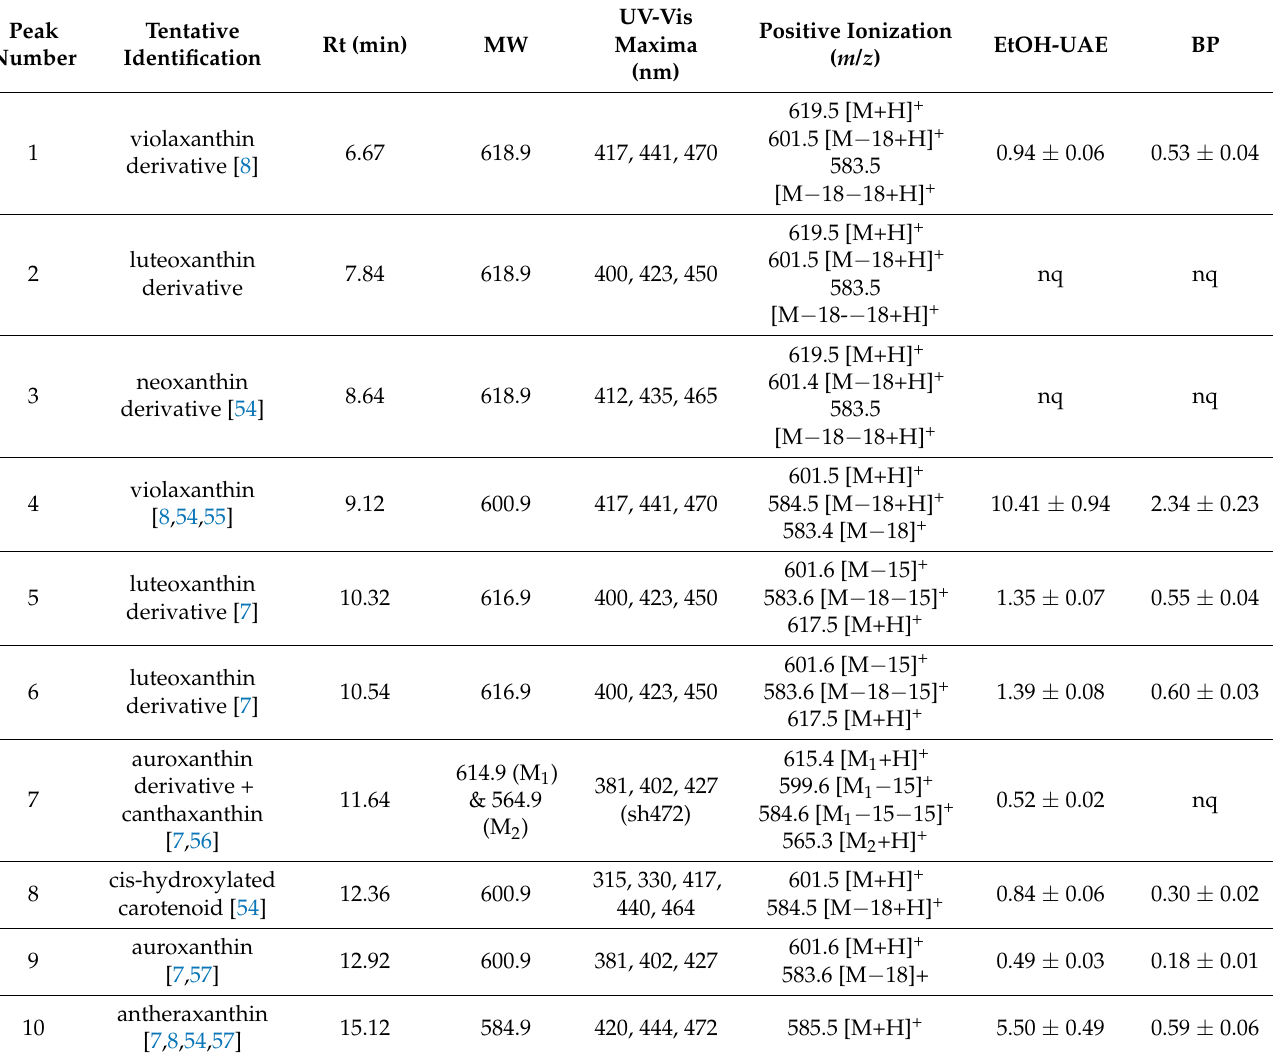
Table 3. Identification and quantification of the main compounds of the two extracts, the EtOH-UAE and the BP. Peaks were tentatively identified after comparison of the UV-vis maxima obtained by the HPLC-DAD and UHPLC-DAD-MS analysis, the ions observed in the mass spectra after UHPLC- DAD-MS, and their elution order to the literature. The retention times of the HPLC-DAD analysis used for quantification are presented. The concentrations (mean ± standard deviation, n = 3) are presented as mg astaxanthin equivalents per g dry original microalgal